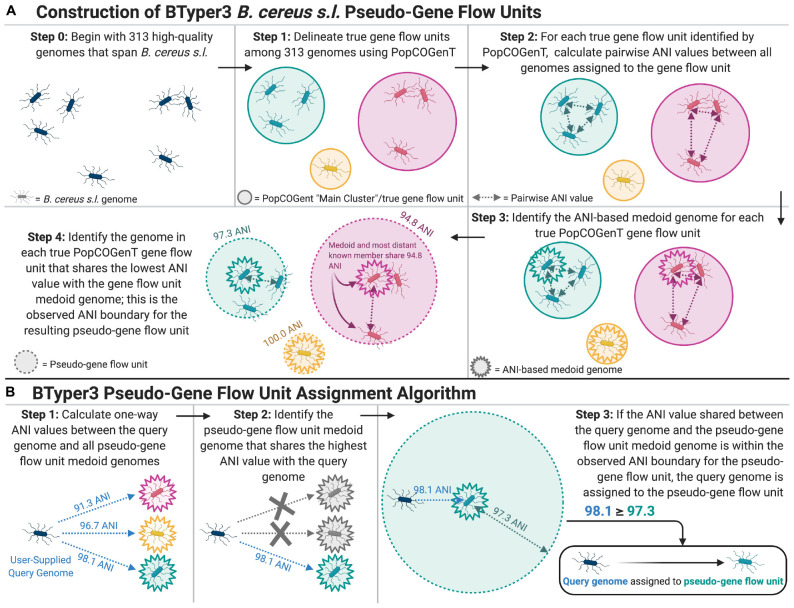
(A) Graphical depiction of the methods used to construct B. cereus s.l. pseudo-gene flow units used by BTyper3. The 313 high-quality B. cereus s.l. genomes (Step 0) were medoid genomes identified among a set of 1,741 high-quality B. cereus s.l. genomes at a 99 average nucleotide identity (ANI) threshold using the bactaxR package in R. This step was performed to remove highly similar genomes and reduce the full set of 1,741 high-quality genomes to a smaller set of genomes that encompassed the diversity of B. cereus s.l. in its entirety. Gene flow units delineated using PopCOGenT (Step 1) were the “main clusters” reported by the PopCOGenT module. (B) Graphical depiction of the pseudo-gene flow unit assignment algorithm implemented in BTyper3. Pseudo-gene flow unit medoid genomes (Steps 1–3) are the output of the steps outlined in (A). If a user-supplied query genome does not fall within the observed ANI boundary of the most similar pseudo-gene flow unit medoid genome (Step 3), the second-through-fifth most similar pseudo-gene flow unit medoid genomes are queried. All ANI values were calculated using FastANI. The figure was created with BioRender (https://biorender.com/).